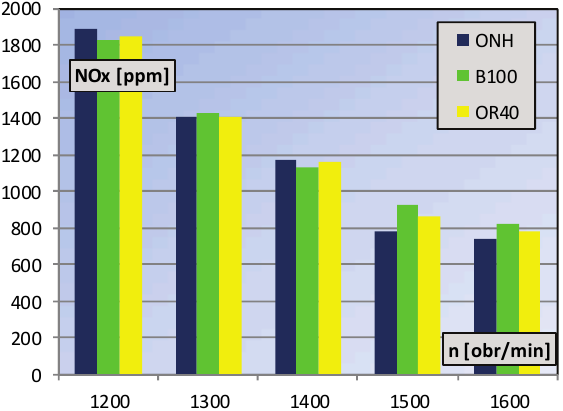
Fig. 8. Concentration of nitrogen oxides NO x in exhaust gases for test engine performance characteristics